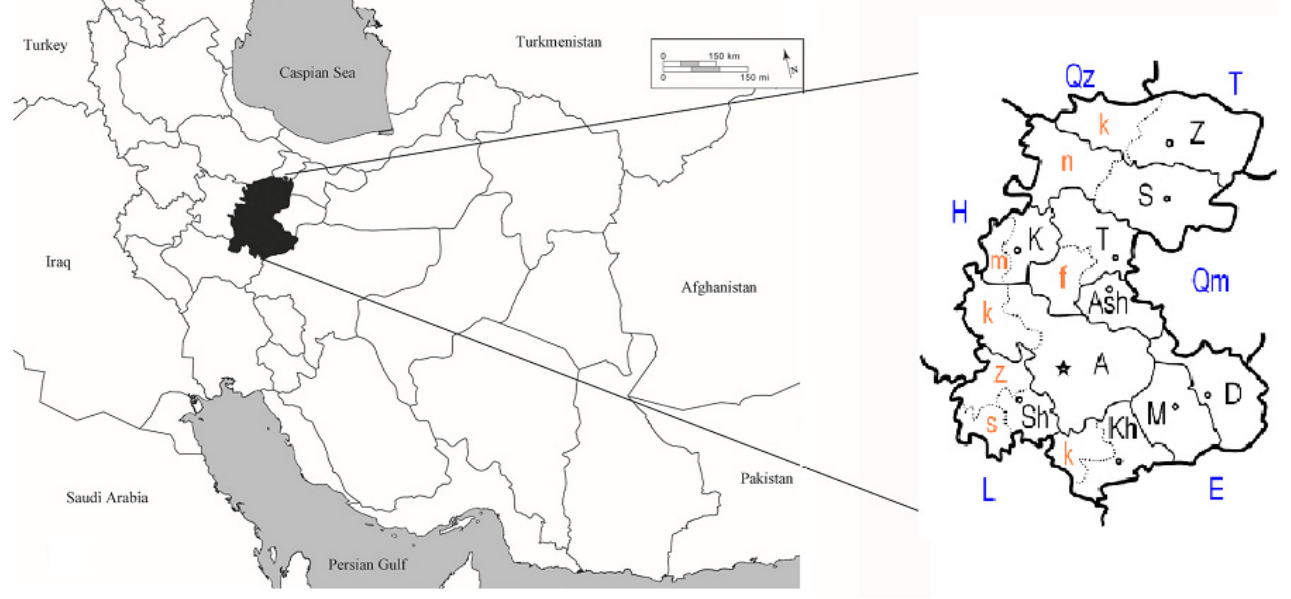
Figure 1. Markazi province’s location in Iran. Note: abbreviated provinces are marked in blue (i.e., Qz = Qazv ī n, T = Tehran, Qm = Qom, E = Isfahan, L = Loristan, H = Hamad ā n); abbreviated coun- ties are marked in black and associated district in green (i.e., from top to bottom: Z = Zarandiyeh, k = Kharqan (center = Mamooniyeh); S = Saveh, n = Nobaran (center = Saveh); T = Tafresh, f = Fara- han (center = Tafresh); K = Komijan, m = Milajerd (center = Komijan); Ash = Ashtian (center = Ashtian); A = Arak, k = Khondab (center = Arak); Sh = Shazand, s = Sarband, z = Zalian (center = Shazand); D = Delijan (center = Delijan); M = Mahallat (center = Mahallat); Kh = Khomein, k = Kamareh (center = Khomein).